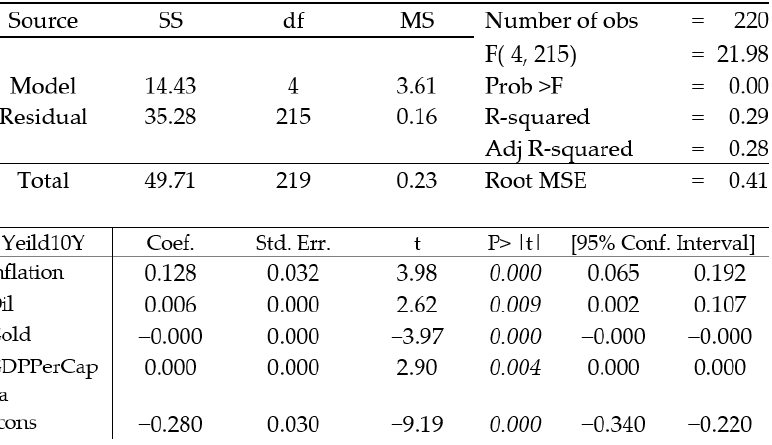
Figure 2. The results of multiple linear regression for the 1st model, including whole analysed macro factors.